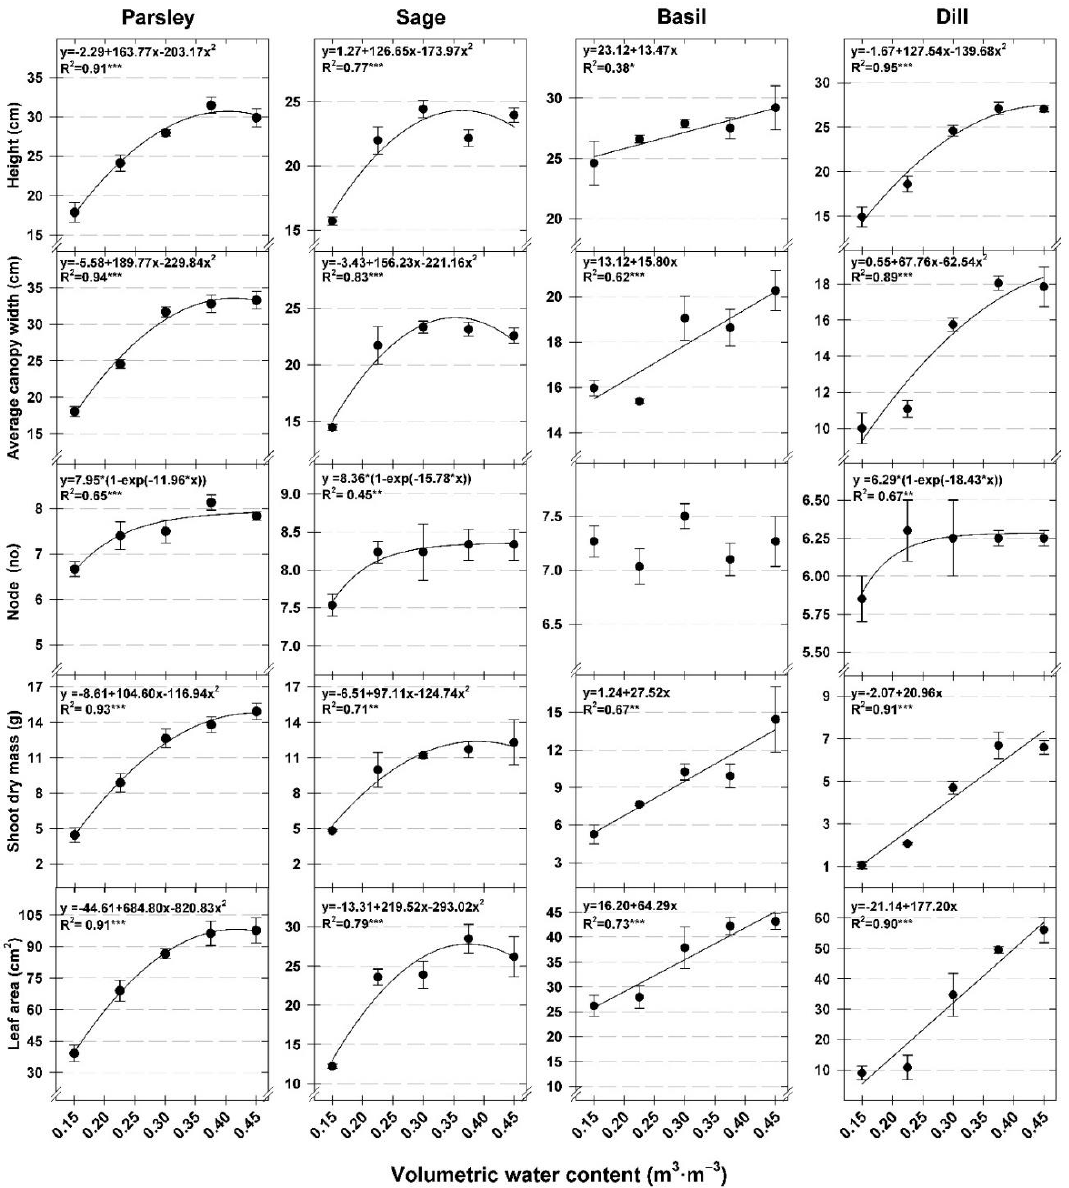
Figure 4. Height, width, node number, leaf area, and shoot dry mass of parsley and sage (Expt. 1) and basil and dill (Expt. 2) grown in 11.4 cm diameter containers filled with a soilless substrate comprising (by vol.) 75% sphagnum peat moss and 25% coarse perlite amended with 3.0 kg · m − 3 controlled-release fertilizer and maintained at 0.15, 0.23, 0.30, 0.38, or 0.45 m 3 · m − 3 substrate volumetric water content for four weeks. Regression lines are presented for significant correlations only with corresponding R 2 presented. *, **, or *** indicates significant at p ≤ 0.05, 0.01, or 0.001, respectively.